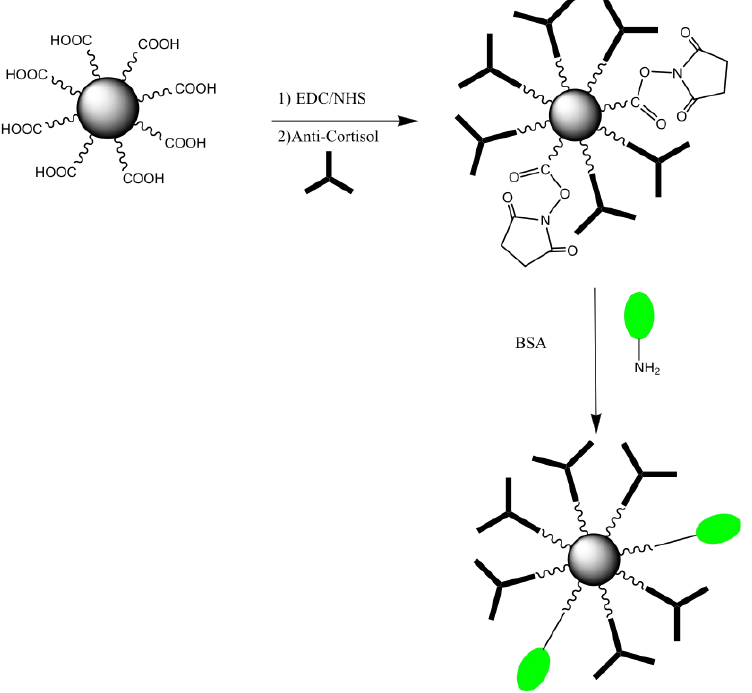
Figure 4. MNPs-COOH biofunctionalization with anti-cortisol antibody.